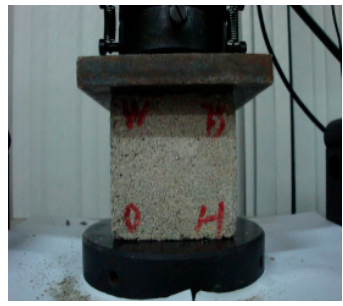
Figure 4. Compression test of mortar prism.